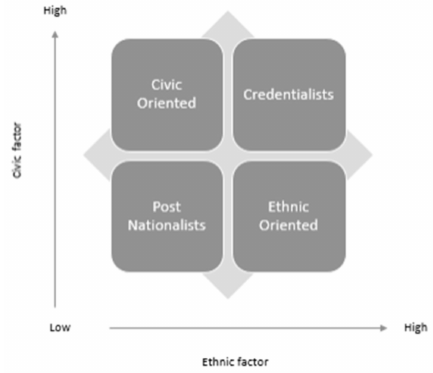
Figure 2. Apostle model applied to National